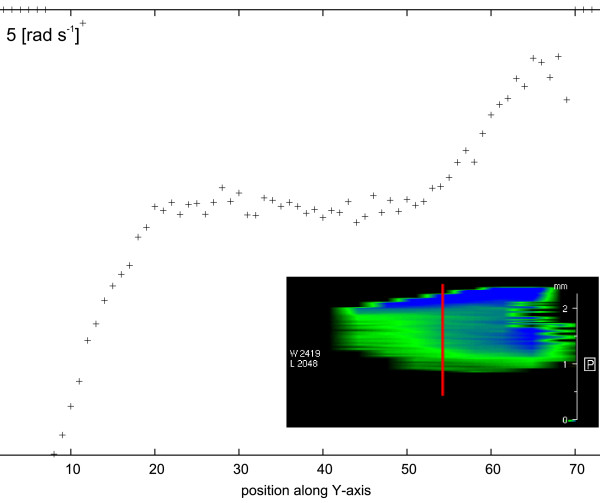
Rheo-NMR measurement showing velocity distribution in 10 wt. % Y2O3in ethyl alcohol at 5.0-rads−1rotor speed.